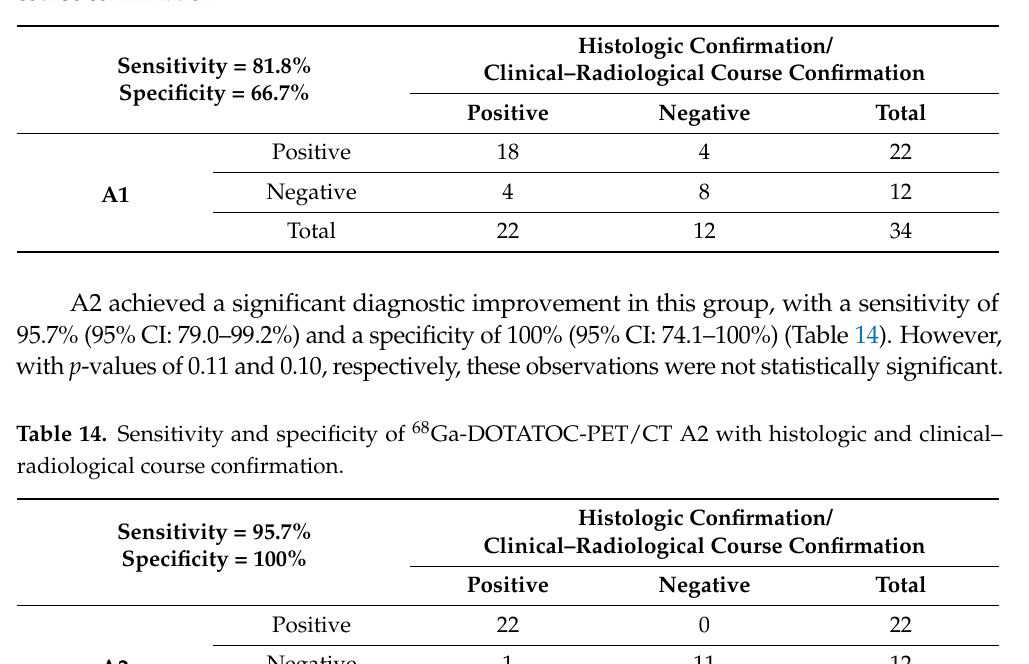
Table 13. Sensitivity and specificity of 68 Ga-PSMA-PET/CT A1 with histologic or clinical–radiological course confirmation.